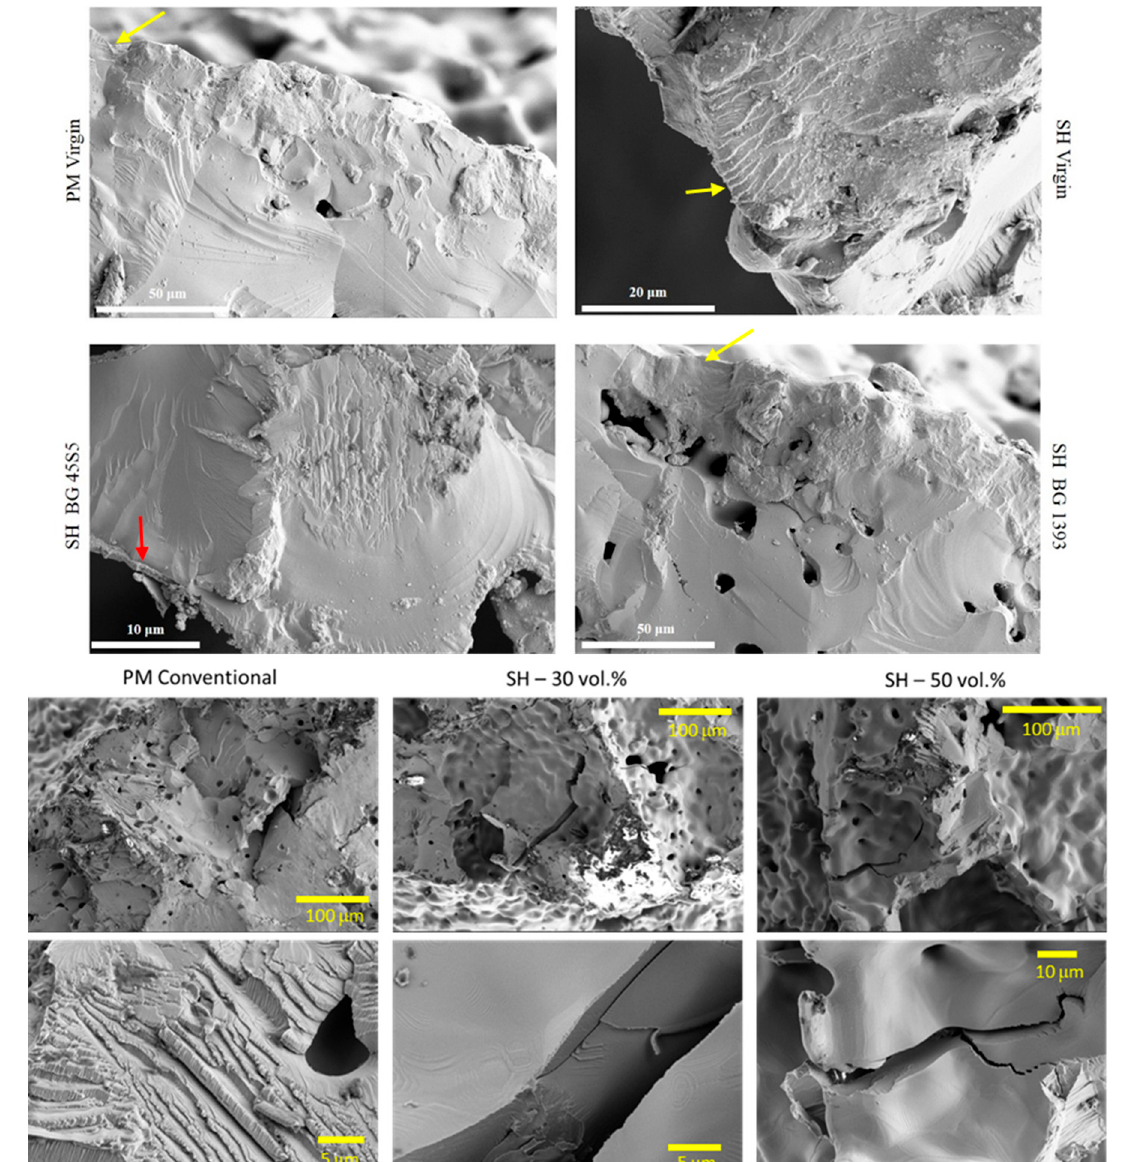
Figure 7. Fracture surfaces under cyclic loads of PM and SH dental implants (virgin and superficially treated), comparing virgin and modified surfaces. Note: Observe the presence of small areas of fatigue striations (see the yellow arrows), and the poor adherence of the BG 45S5 coating (see the red arrow).